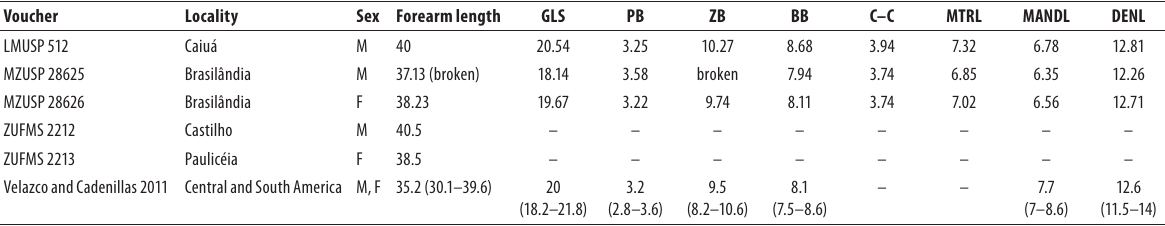
Table 2. Forearm length and standard cranial measurements (in mm) of Lophostoma brasiliense from São Paulo and Mato Grosso do Sul, southeastern Brazil. Data from Velazco and Cadenillas (2011) are the mean and range of measurements of 78 specimens from Central and South America. GLS = greatest length of skull; PB = post orbital breadth; ZB = zygomatic breadth; BB = braincase breadth; C–C = distance across upper canines; MTRL = maxillary toothrow length; MANDL = mandibular toothrow length; DENL = dentary length.